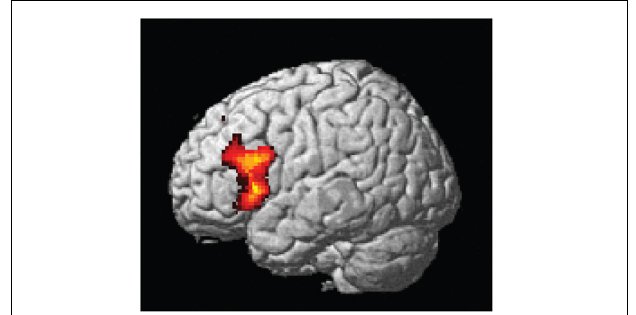
FIGURE 7 | Learning effect with respect to grammaticality status. Comparing the grammaticality effect (NG > G) during preference classification on day 5 and day 1 yielded significant effects in the inferior frontal (left and right: P FWE < 0 . 001), the medial prefrontal ( P FWE < 0 . 001; not shown)